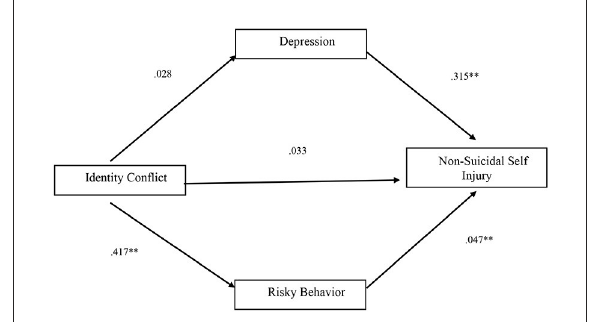
FIGURE2 Pathways to non-suicide self-injury among druze adolescents. ** p < 0.01. Note. Standardized regression coefficients are